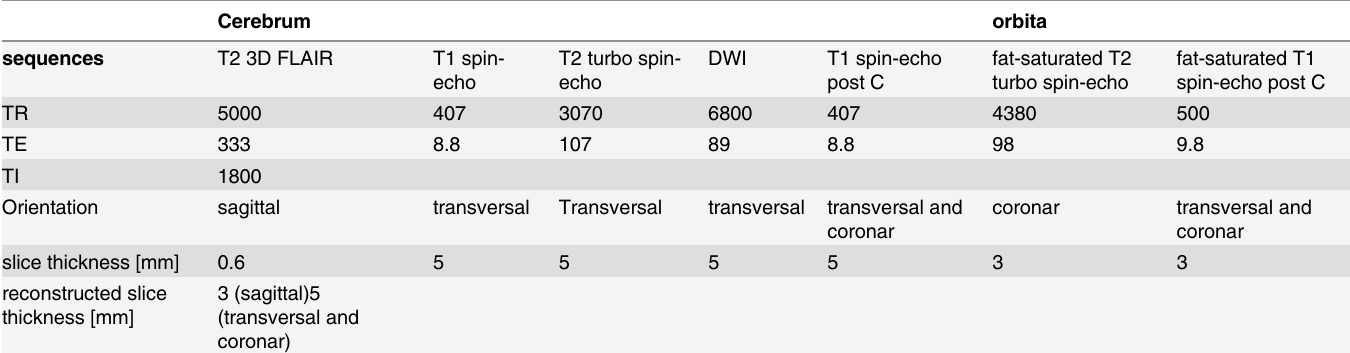
Table 1. MR imaging